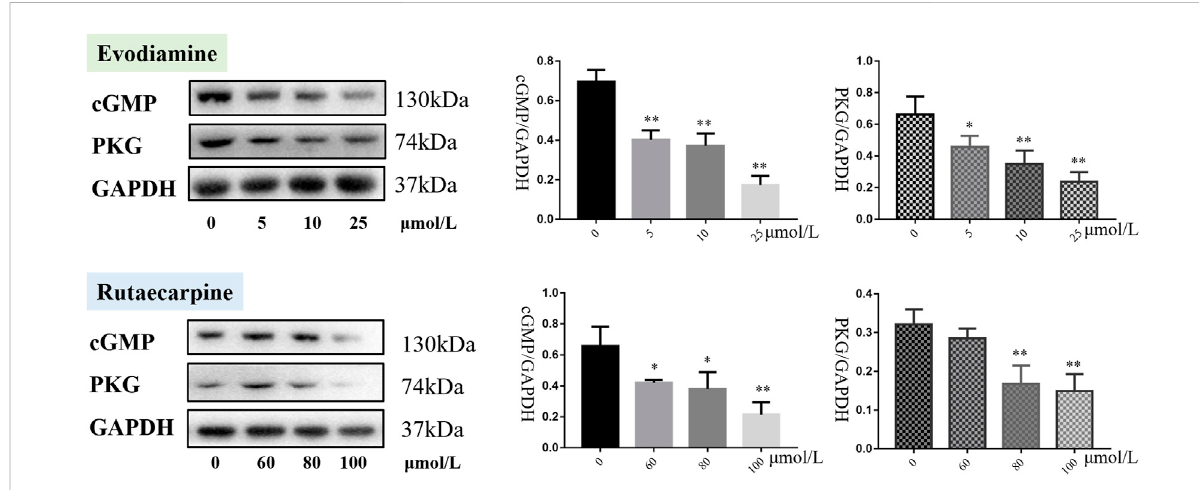
FIGURE 3 Protein expression of cGMP-PKG pathway of evodiamine and rutaecarpine.